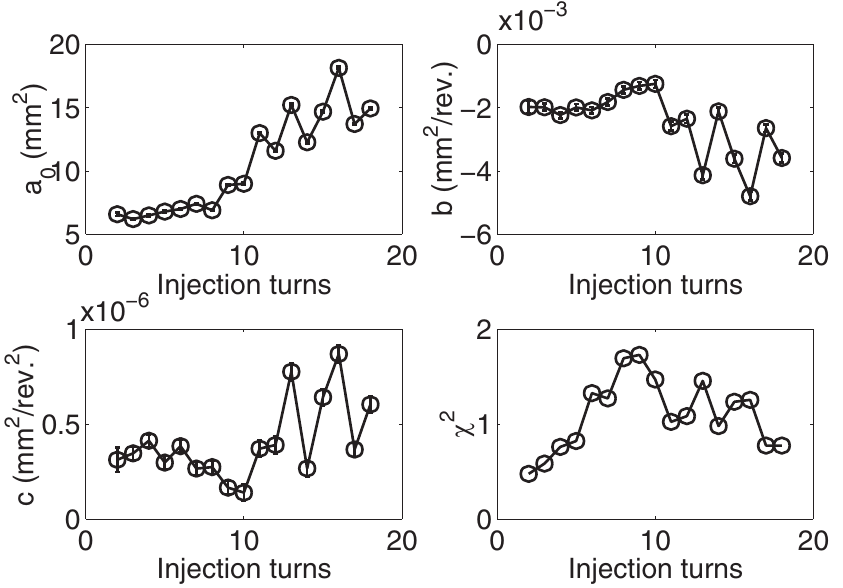
FIG. 24. The fitting parameters of the post-transition horizontal beam size (cid:2) 2 ( mm 2 = revolution) at top right; parameter c ( mm 2 = revolution 2 ) at bottom left; and bottom right: the residual (cid:9) 2 normalized by noise sigma and number of data